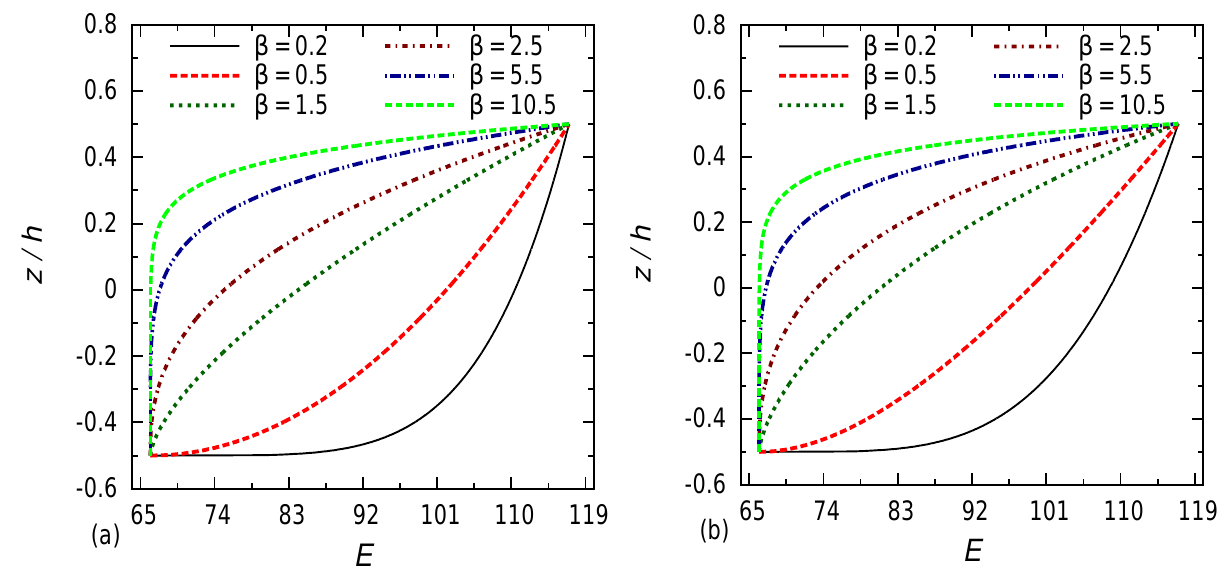
Figure 2. Variation of Young’s modulus E through the thickness of the FG nanoplate for various values of the FG parameter β according to the two gradation models ( a ) model 1 and ( b ) model